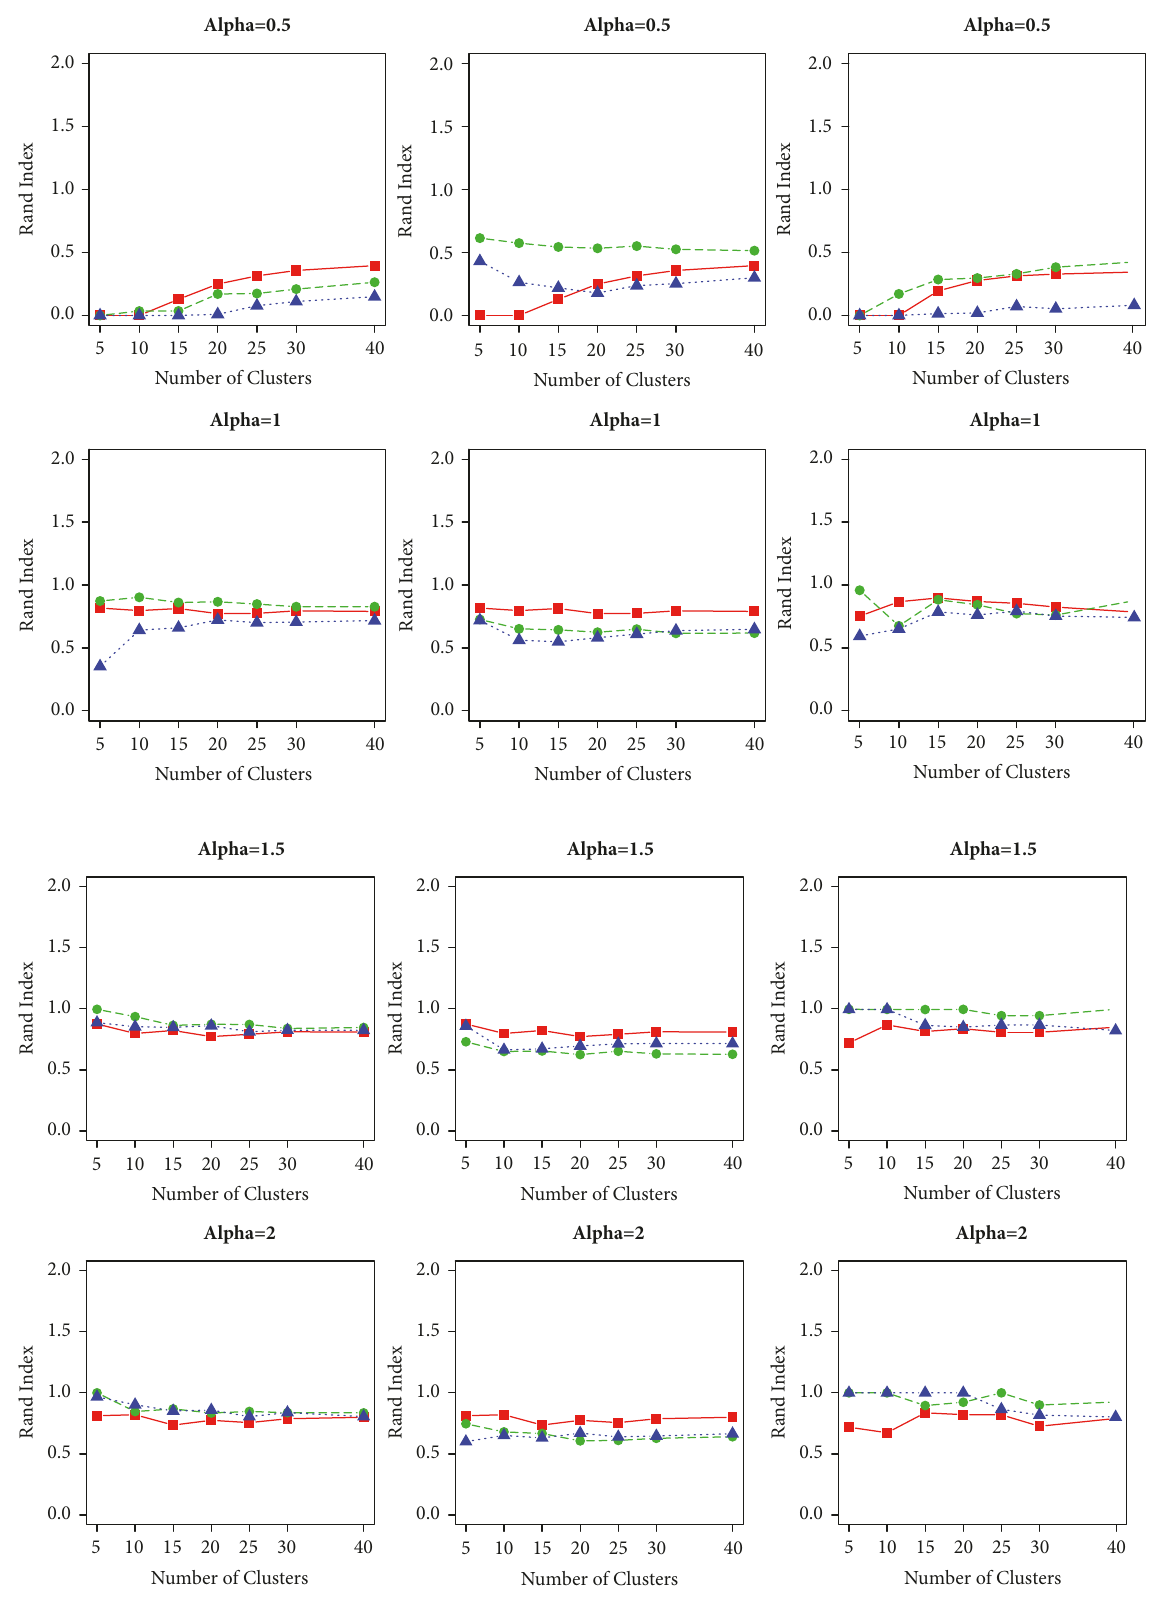
Figure 1: Comparison of KM, CM, and KCM algorithms in terms of accuracy based on Euclidean, Manhattan, and Minkowski ( 𝑝 = 1.5) distances for 𝛼 = 0.5, 1, 1.5, 2. KM: Red squares, CM: Green circles, KCM: Blue